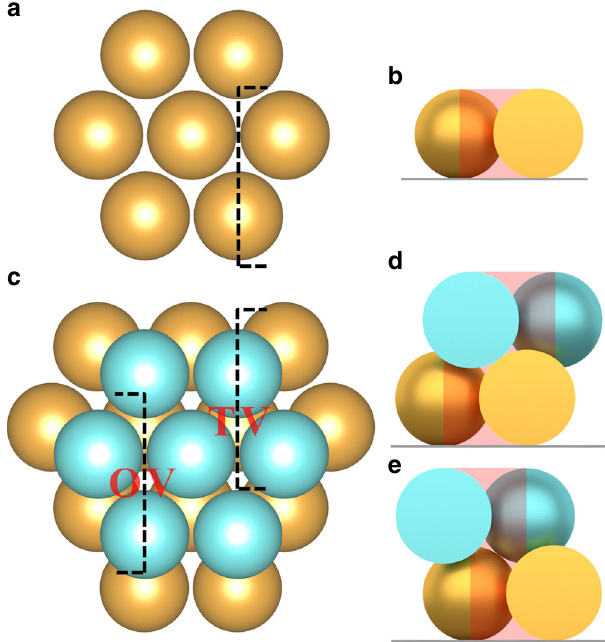
Fig. 4 Schematic illustration of the early stage of the SC growth. a The fi rst hexagonal monolayer of NPs. b Cross-section as marked by dashed line in a . c Two consecutive monolayers and cross-sections showing d a TV and e an OV. The red shades outline the free space in these